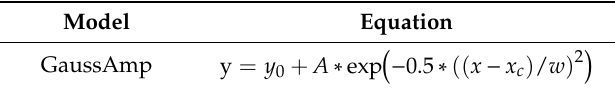
Table 1. Models and equations used in the fitting.